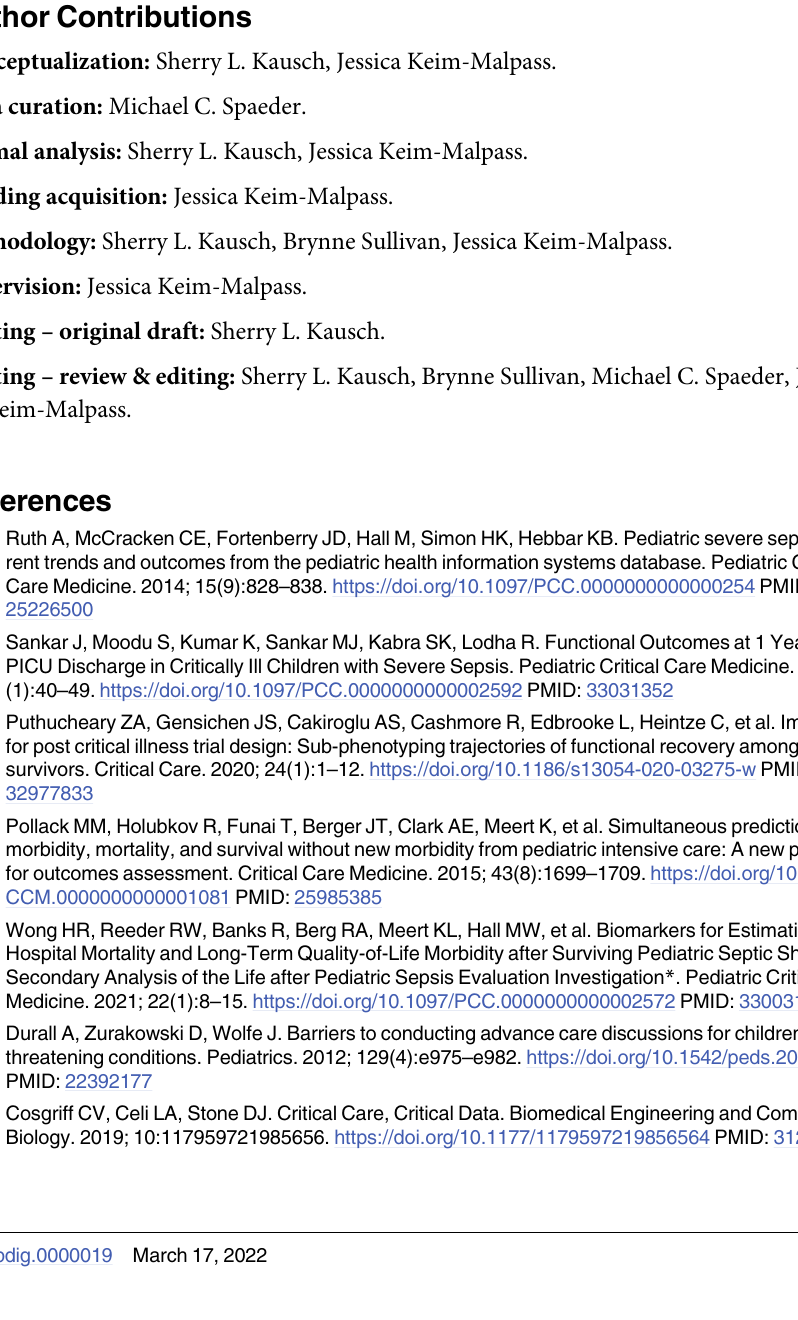
S1 Fig. A scatter plot to show the association between illness score and entropy.